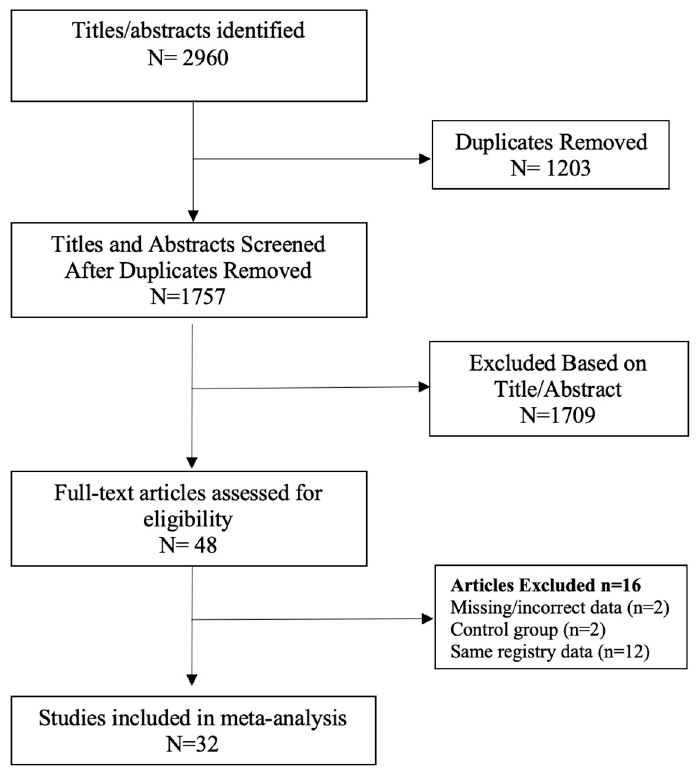
Figure 1. PRISMA flow chart Figure 1. PRISMA fl ow chart [34,35].